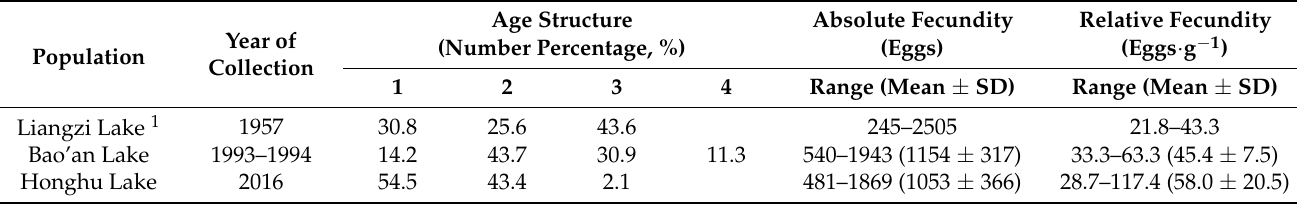
Table 1. Life-history traits of Odontobutis sinensis collected from Honghu Lake in 2016, in comparison with two historical populations in the middle Yangtze River, China.